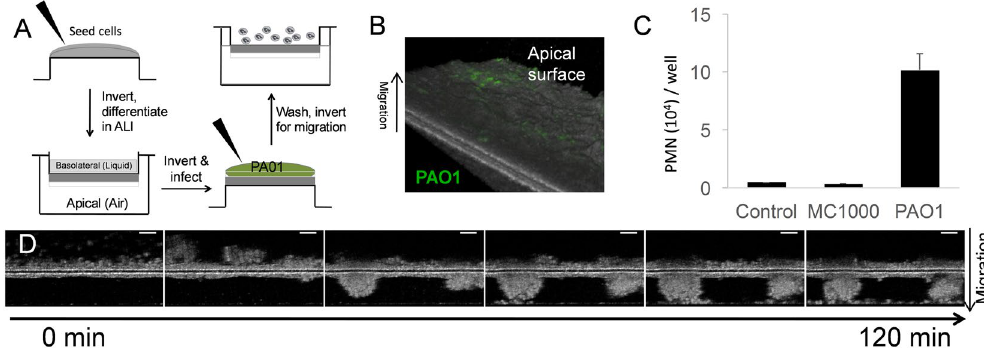
Figure 3. Infection with Pseudomonas aeruginosa induces neutrophil migration across the human airway basal cell-derived epithelium. ( A ) Schematic of neutrophil migration induced by PAO1 infection is shown. ( B ) GFP-expressing PAO1 was visualized on mucosal layer of human airway basal cell-derived epithelium using fluorescence-enhanced µ OCT imaging. ( C ) Neutrophil migration across human airway basal cell-derived epithelium was assessed by MPO activity in response to epithelial infection with PAO1 and a non-pathogenic E.coli , MC1000, performed in triplicate and replicated > 3 times with similar results. ( D ) Progressive